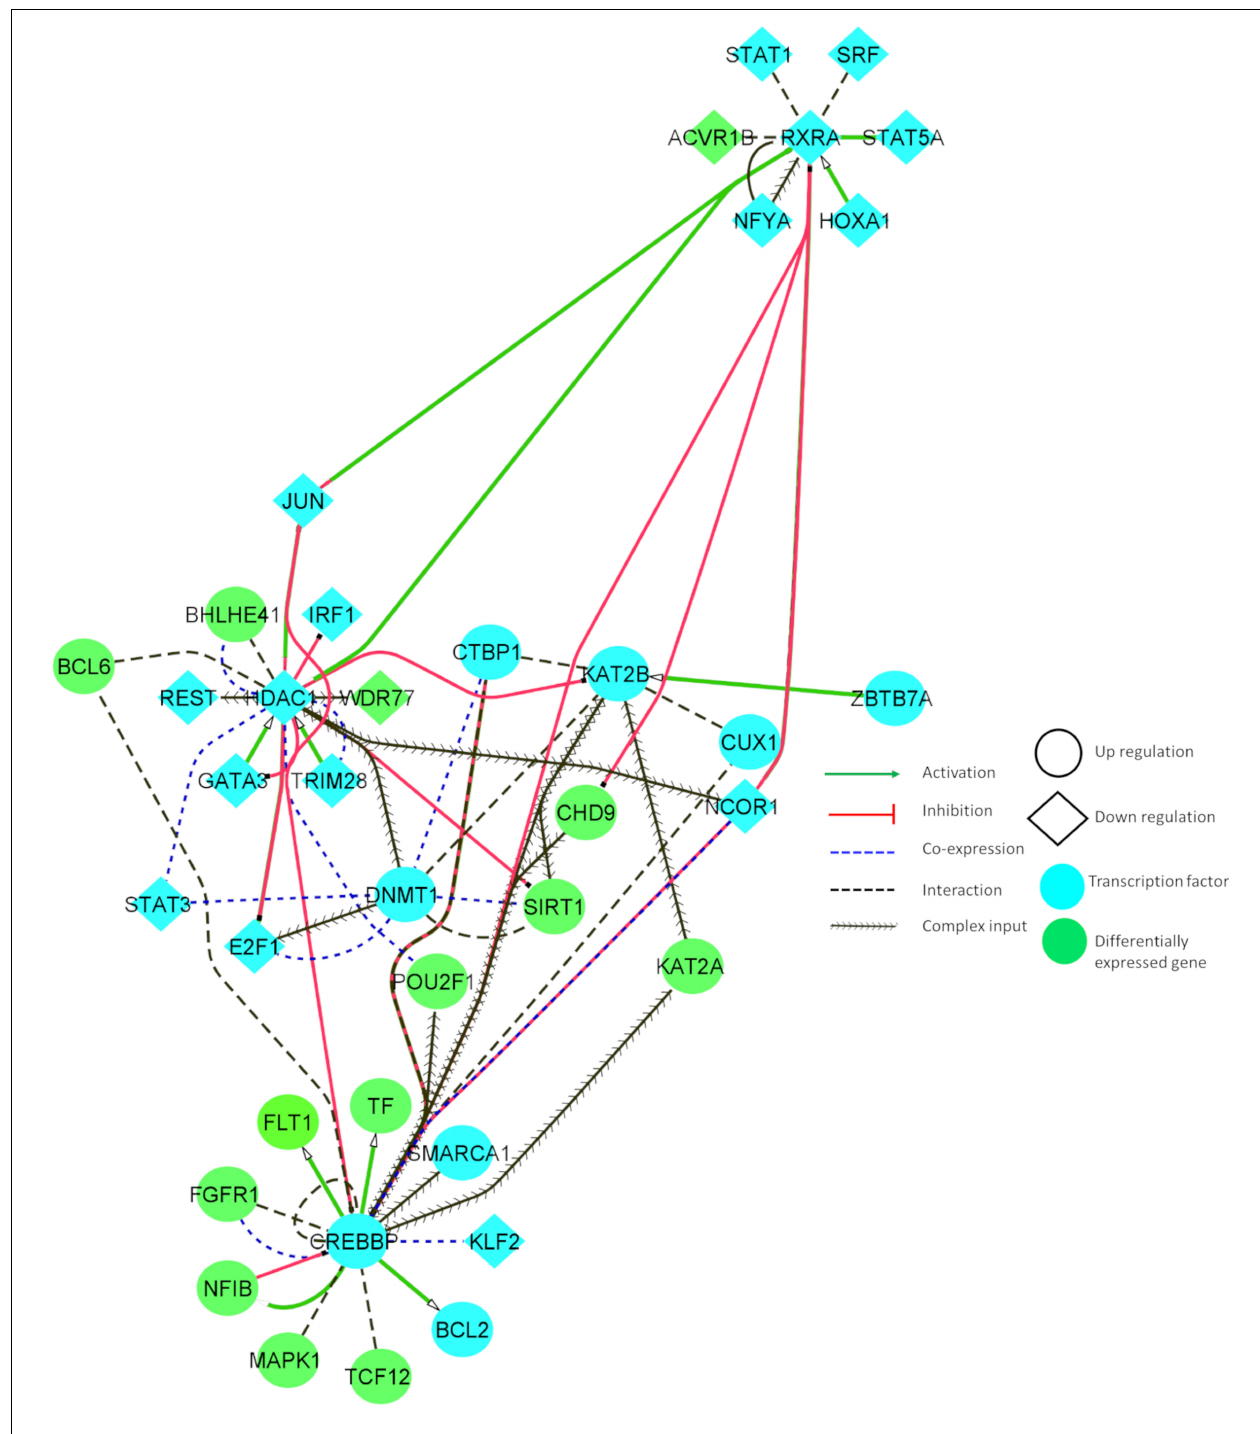
FIGURE 4 | Tissue-specific (BA9) functional interaction network between transcription factors and differentially expressed genes involved in AD and PD.